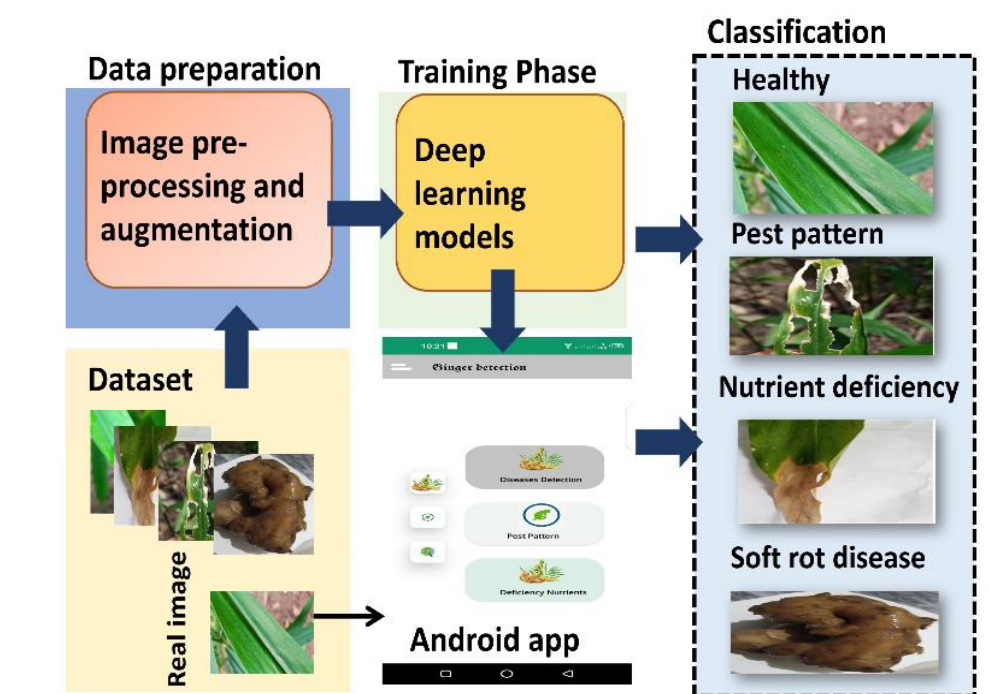
Figure 1. A general framework of the work: the dataset is collected and pre-processed. Then, deep learning models are used for training and testing and further integrated into an android application to provide a real-time ginger disorder identification mechanism.